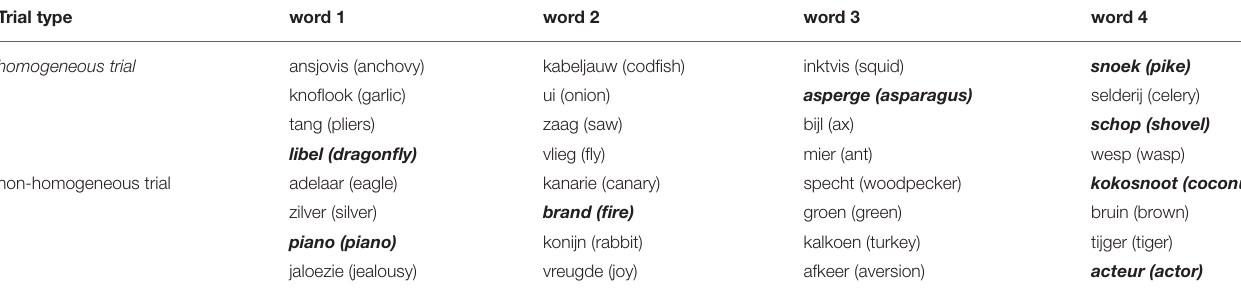
TABLE 1 | Example